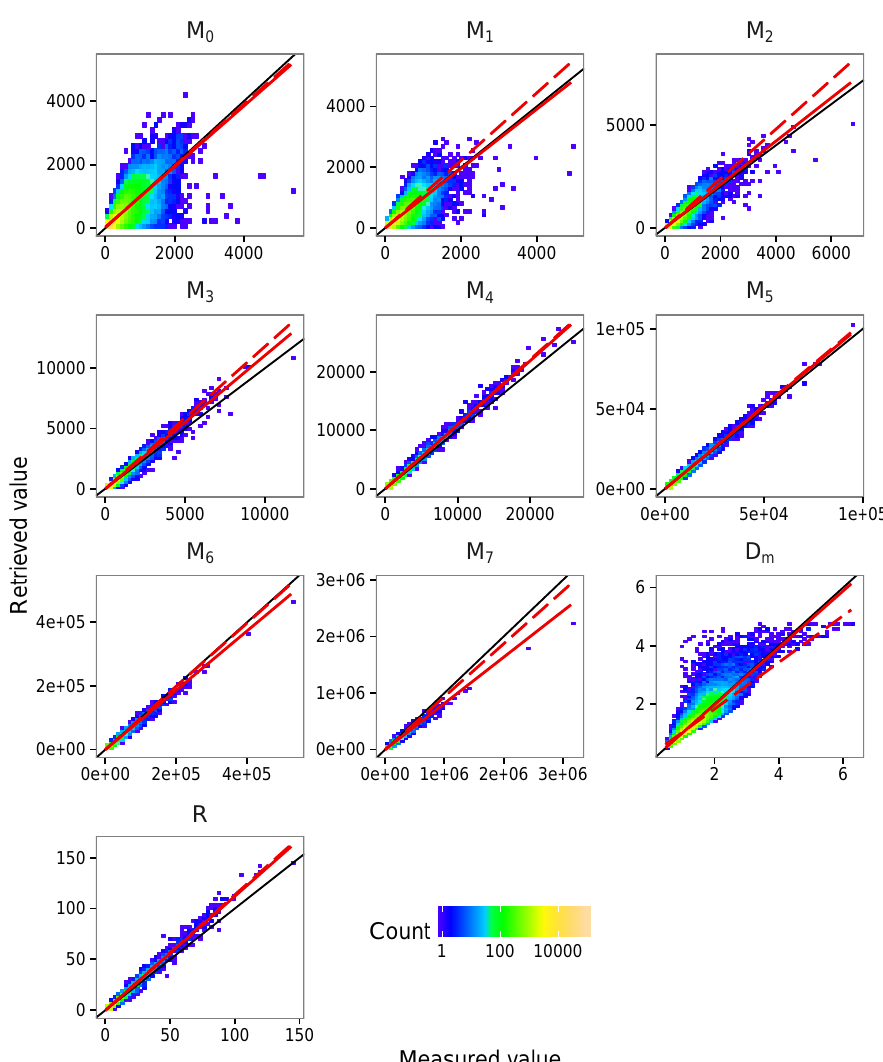
Figure 3. Density scatter plots of retrieved vs. measured moments M n (mm n m − 3 ), R (mmh − 1 ), and D m (mm) for the double-moment method, on the HyMeX data set, using the axis ratio function of Beard and Chuang (1987). One-to-one lines are shown in black. Regression lines for the double-moment method are shown in solid red, and dotted red lines show linear regressions for SCOP-ME, for which the densities are not